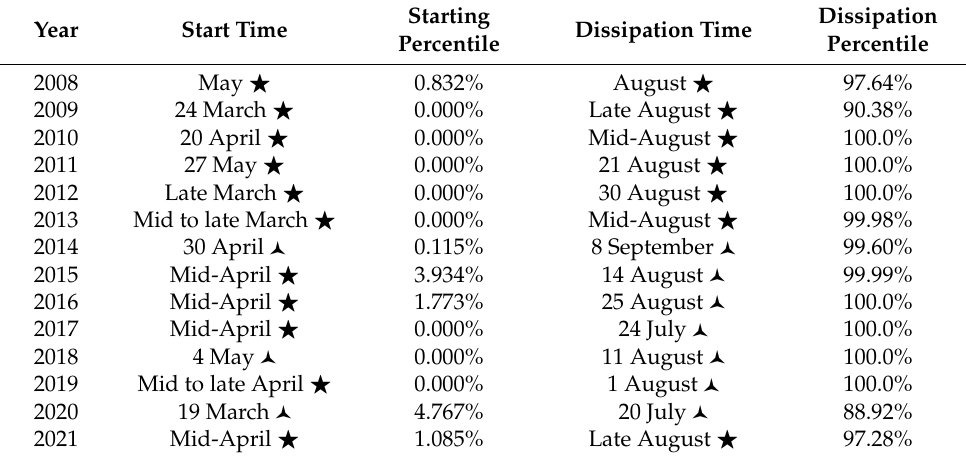
Table 8. Start and dissipation times of the green tide event.